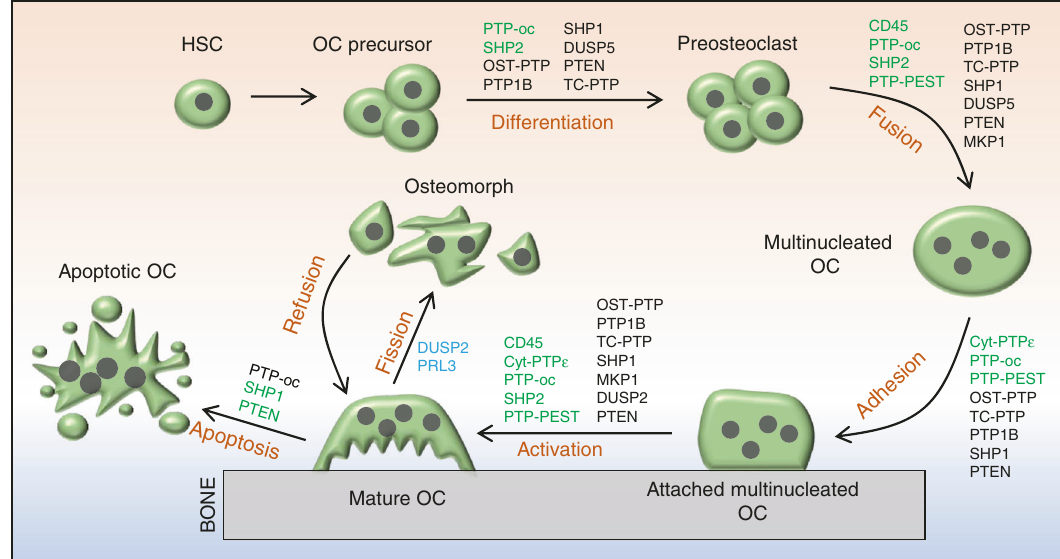
Fig. 6 Schematic diagrams depicting the classical osteoclastogenic processes and novel osteoclast fi ssion in which PTPs are implicated as playing a regulatory role. PTPs denoted in green or black indicate that they positively or negatively, respectively, modulate the commitment and differentiation of HSCs to myeloid cells, the fusion of OC precursors, and the adhesion, activation, and apoptosis of OCs. DUSP2 and PRL3 are reported to be highly expressed in osteomorphs, suggesting that they play a role in the fi ssion of OCs. Their speci fi c mechanism and function remain unclear, and they are denoted in